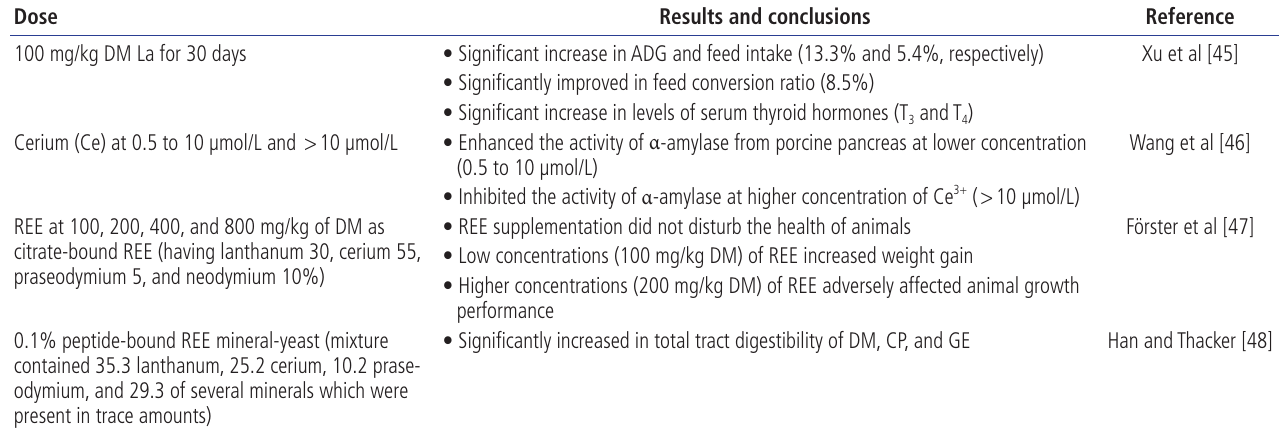
Table 1. Literature summary of effect of REE supplementation in pigs Dose